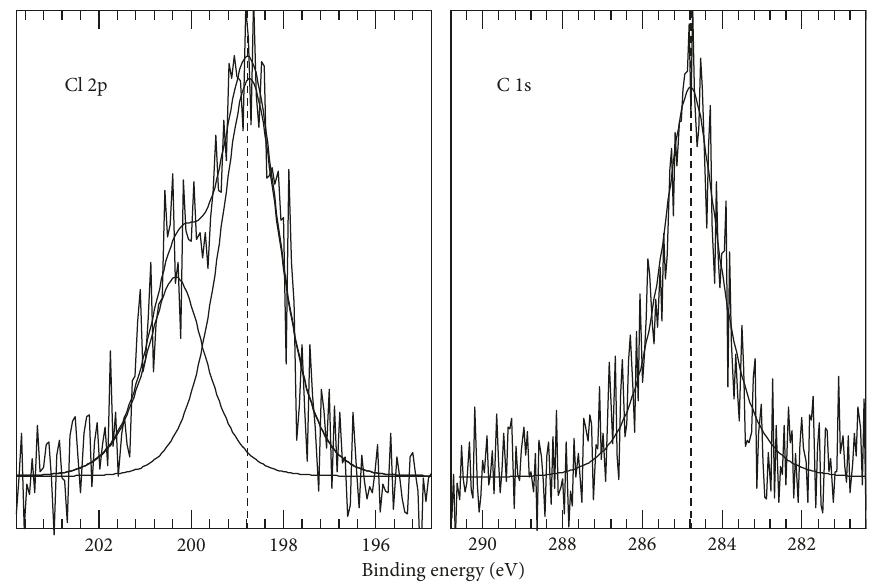
Table 3: XPS surface composition of ZnO, Zn(OH) · H 2 , Zn 5 (OH) 8 Cl 2 2 O, ZnCO 3 , and Zn 5 (CO 3 ) 2 (OH) 6 powders prepared by the pre- cipitation method and shares of oxygen and zinc bonds. The share of oxygen bonds with Atomic composition (at.%) Compound